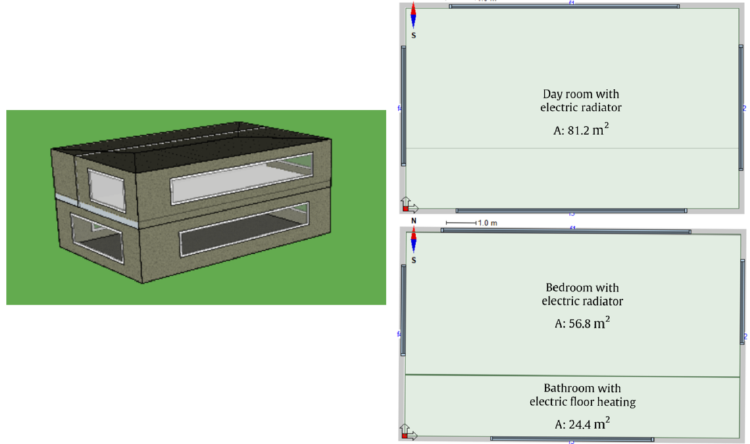
Figure 6. Layout and appearance of a representative single-family house with a floor area of 162 m 2